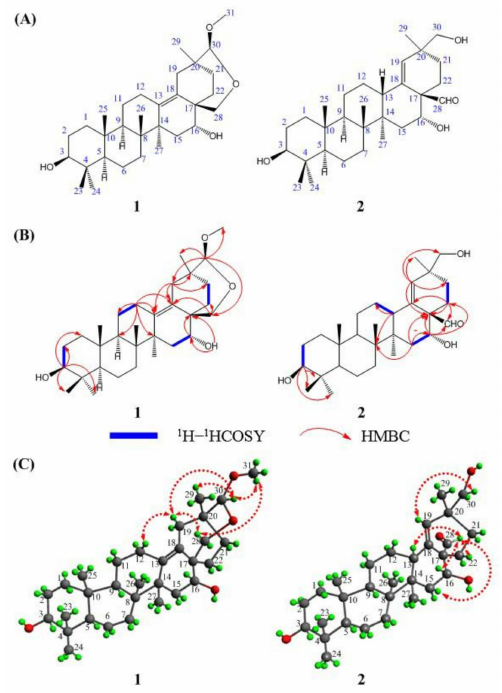
Figure 1. Chemical structures ( A ), key 1 H– 1 HCOSY and HMBC correlations ( B ), and NOESY correla- tions ( C ) of compounds 1 and 2